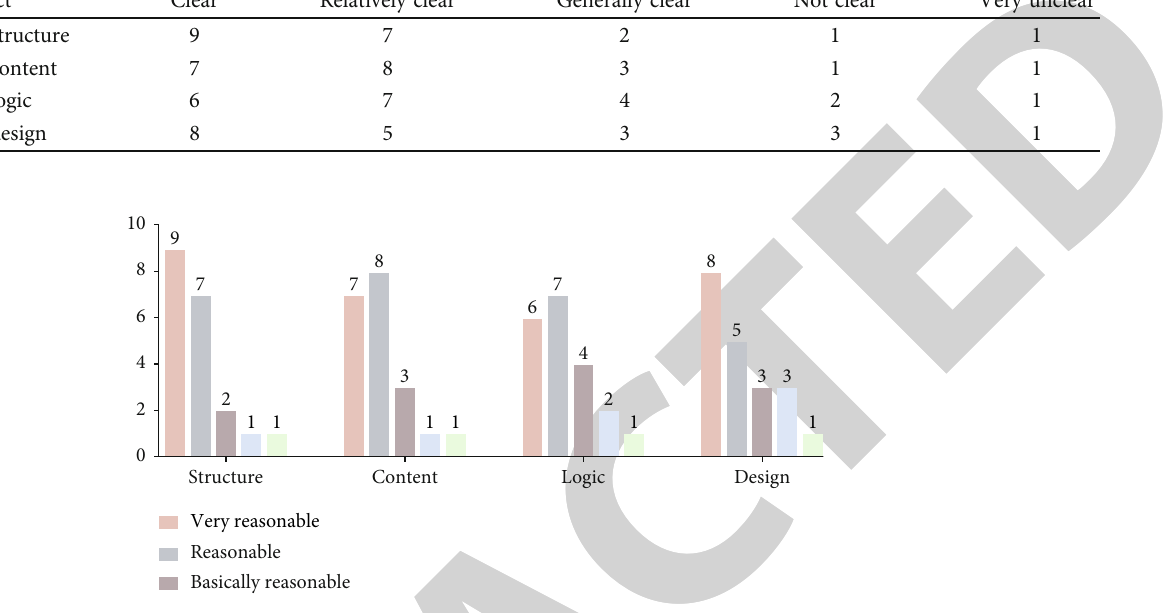
Figure 7: Questionnaire validity